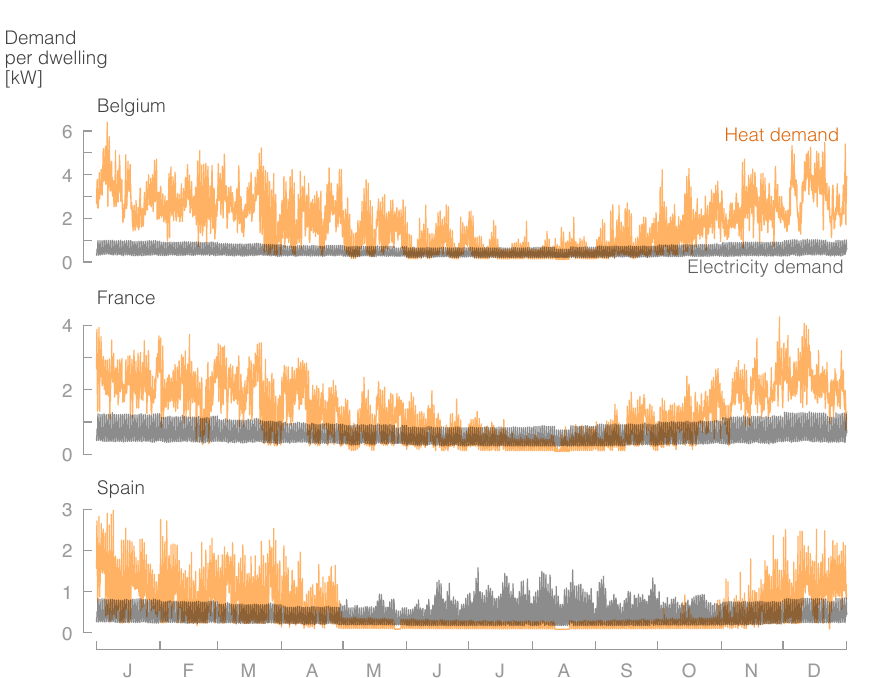
Figure 7. The hourly heat and electricity demands follow similar patterns in France and Belgium; nevertheless, in Spain, they differ: the shorter winters result in a minimum heat demand from May until November, and the use of air conditioning is obvious from an increased electricity demand in the